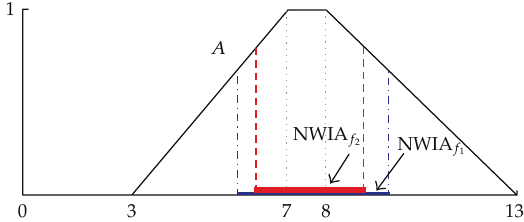
Figure 3: Trapezoidal fuzzy number and its interval